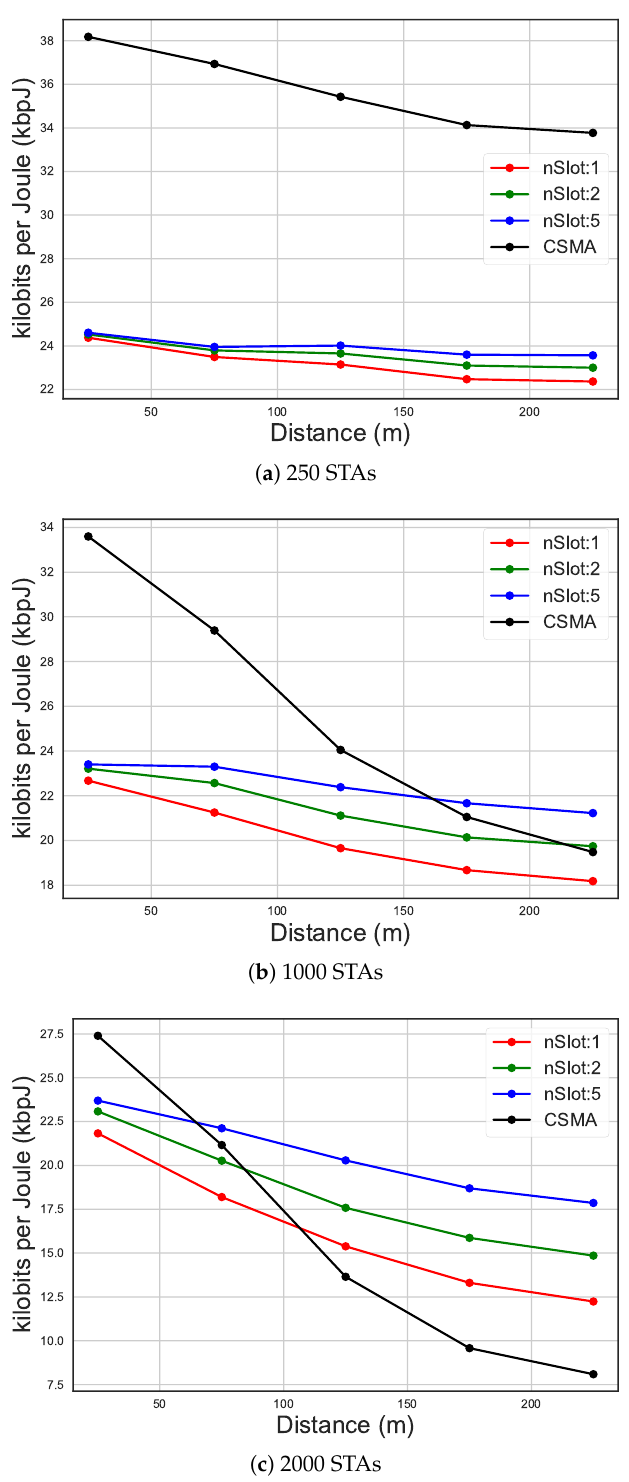
Figure 12. Energy efficiency on distance, comparing CSMA/CA and the usage of 10 RAW groups and one, two and five slots per group, using 30 s as average packet arrival